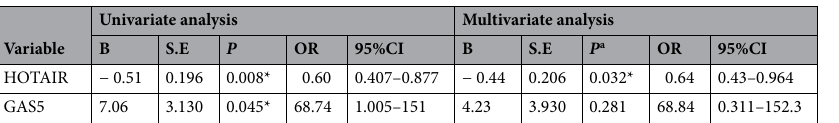
Table 3. Plasma lncRNAs as predictors of overall response to R-CHOP in DLBCL patients. HOTAIR and GAS5 were included in a multivariate analysis with age, sex, family history and IPI score as covariates. − 2 Log likelihood of the best model, P < 0.0001. a Adjusted with age, sex, family history and IPI score. *Indicates statistical significance ( P <